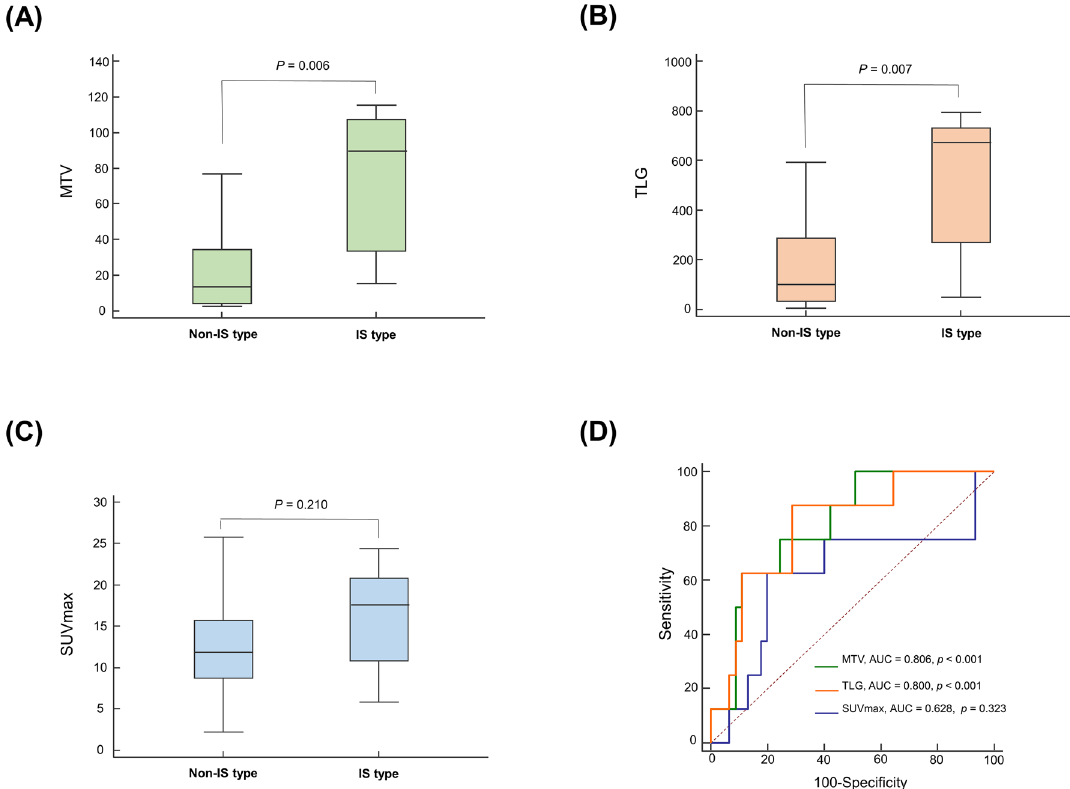
Figure 1. Box-whisker plots for metabolic tumor volume (MTV; A ), total lesion glycolysis (TLG; B ), and SUVmax ( C ) between non-IS and IS TIME subtypes in ENKTL patients with extra-nasal involvement. ( D ) ROC curves illustrating performance of SUVmax, MTV, and TLG for differentiating IS from non-IS subtypes. IS, immune